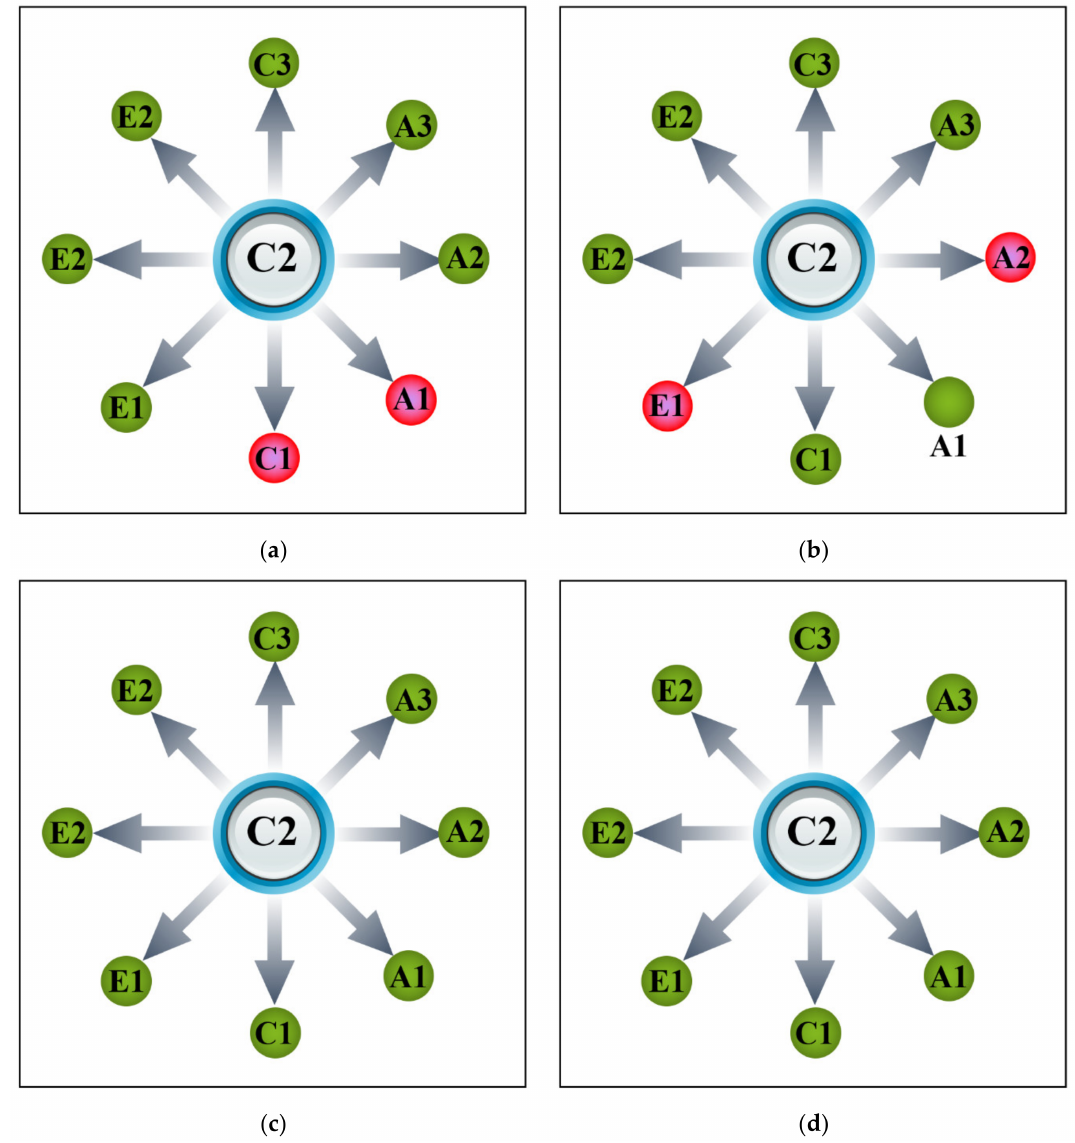
Figure 5. Tukey Pairwise comparison between the control sensor and other sensors for T ( a ), RH ( b ), T dp ( c ), and VPD ( d ) in DLG. (Significant, Nonsignificant @ p <